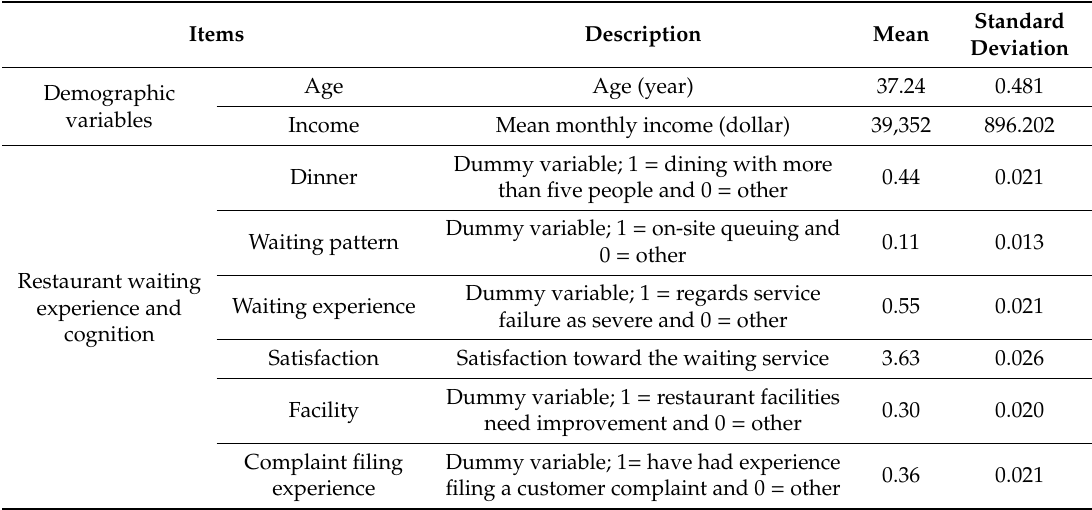
Table 4. Settings and description of variables for WTW associated with waiting service recovery provided by the restaurant.